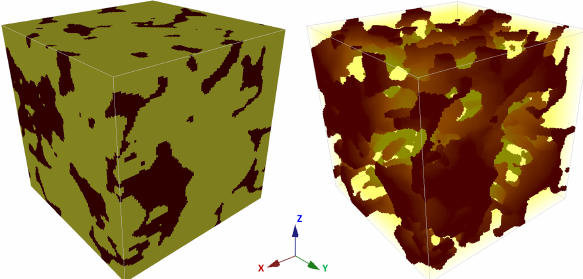
Figure 4. A sample of Berea sandstone from Okabe and Blunt (2007) is used as a 3-D reference (100 × 100 × 100 voxels). The crimson color represents pores and the yellow color represents a matrix. The porosity of this model is 20.33%.